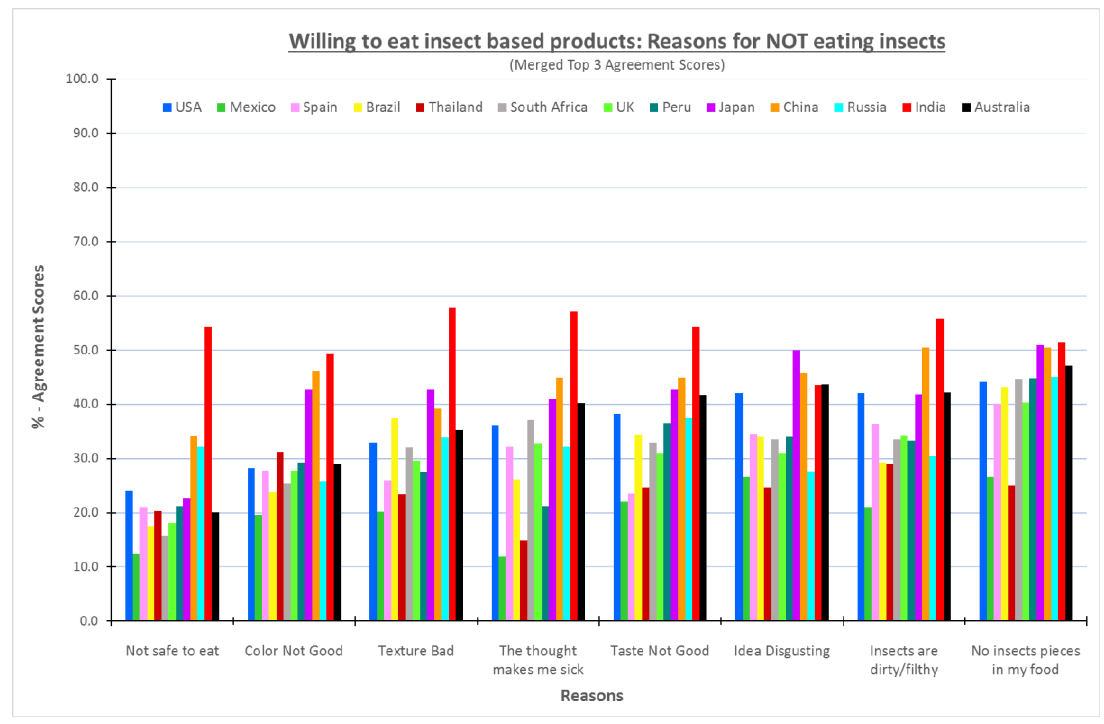
Figure 2. A graph of the reasons for not eating insect based products—consumers willing to try.